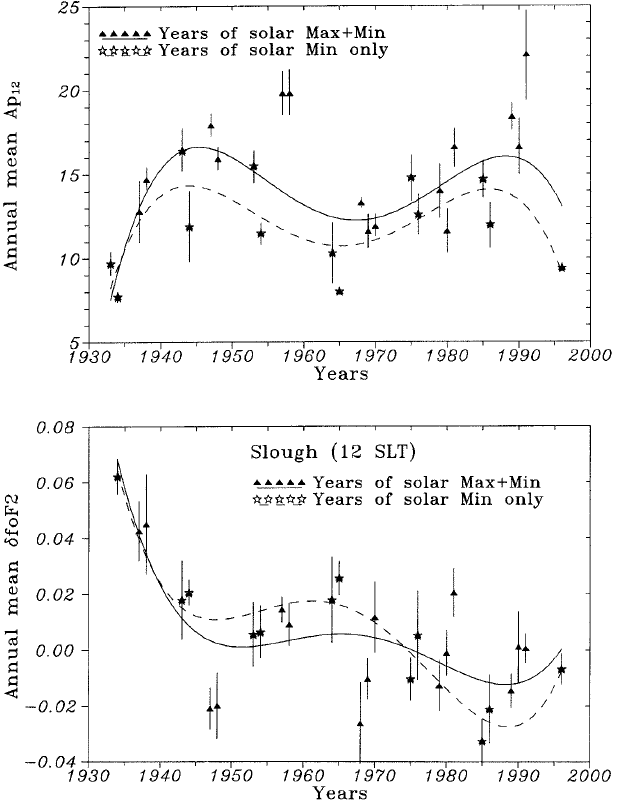
Fig. 4. Annual mean Ap and d f oF2 at Slough long-term variations. 12 Two year selections ( M + m ) and ( m ) (see text) are used for the analysis. Least squares fitting curves are a 4th degree polynomials. Error bars present the standard deviation of the seasonal (over 12 months) scatter